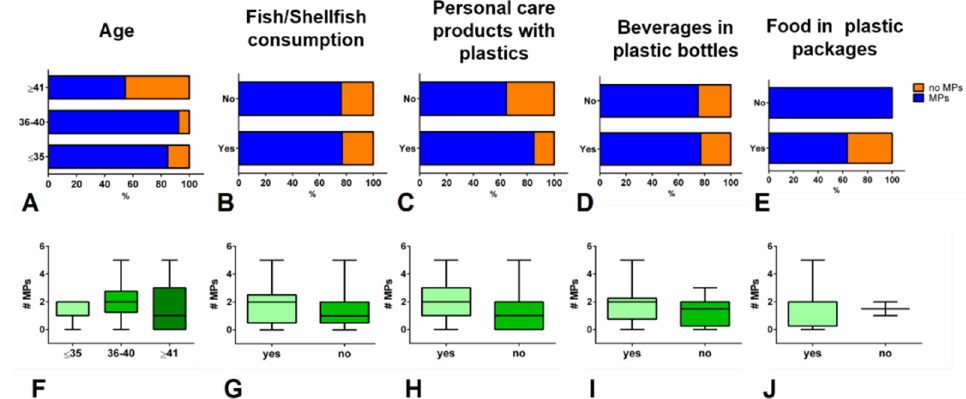
Figure 3. Percentage abundances of samples with (MPs) and without (no MPs) microplastics, divided according to the following selected parameters: ( A ) age of patient; ( B ) consumption of fish/shellfish in the 7 days prior to the expected date of delivery and 7 days after; ( C ) use of personal care products with plastic compounds in the 7 days prior to the expected date of delivery and 7 days after; ( D ) consumption of beverages in plastic bottles in the 7 days prior to the expected date of delivery and 7 days after, and ( E ) consumption of food in plastic packaging in the 7 days prior to the expected date of delivery and 7 days after. Number of identified microplastics divided according to the above-defined parameters ( F – J ) (box charts: centre line marks the median, edges indicate the 5th and 95th percentiles, and whiskers indicate the minimum and maximum values).